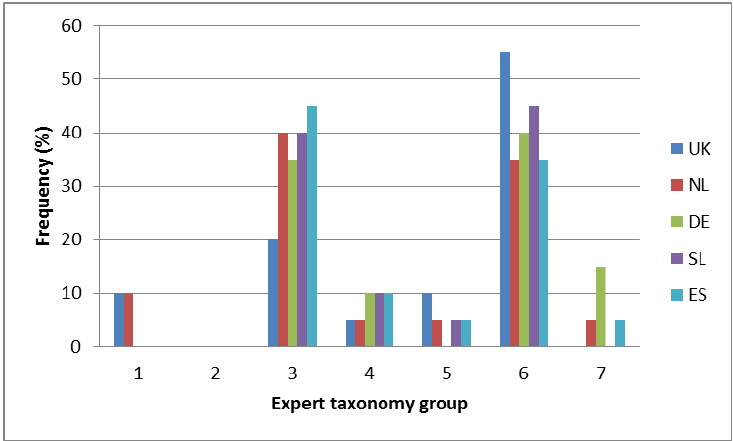
Figure A4. Frequency of structured sort placement of nutrition claims per country—‘No added sugar’ (Card 22).